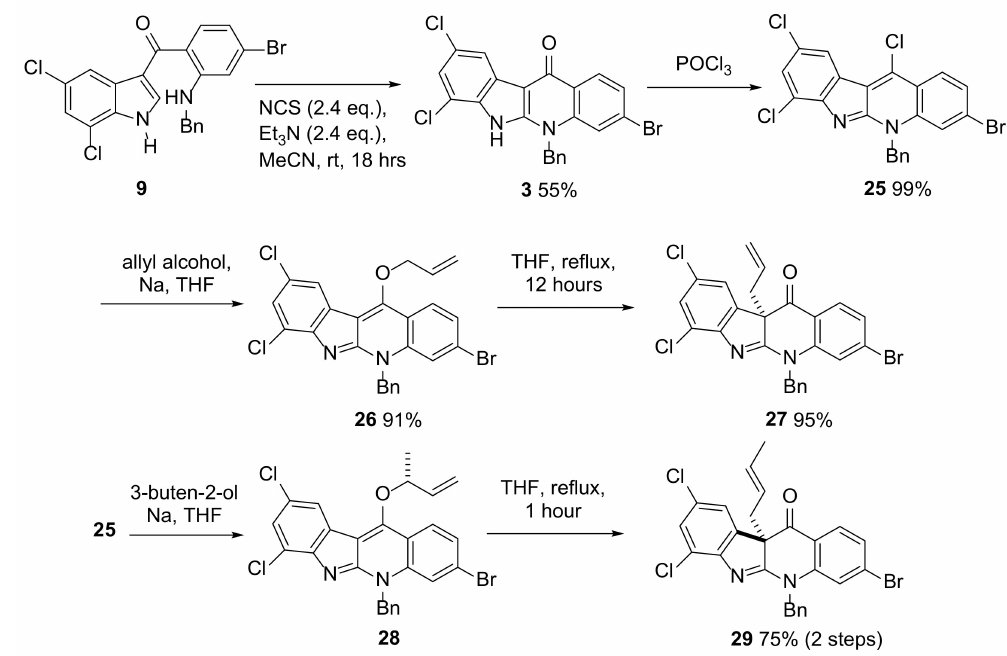
Scheme 6. Optimized conditions for the conversion of 9 to 3 and instalment of an all-carbon quaternary center in